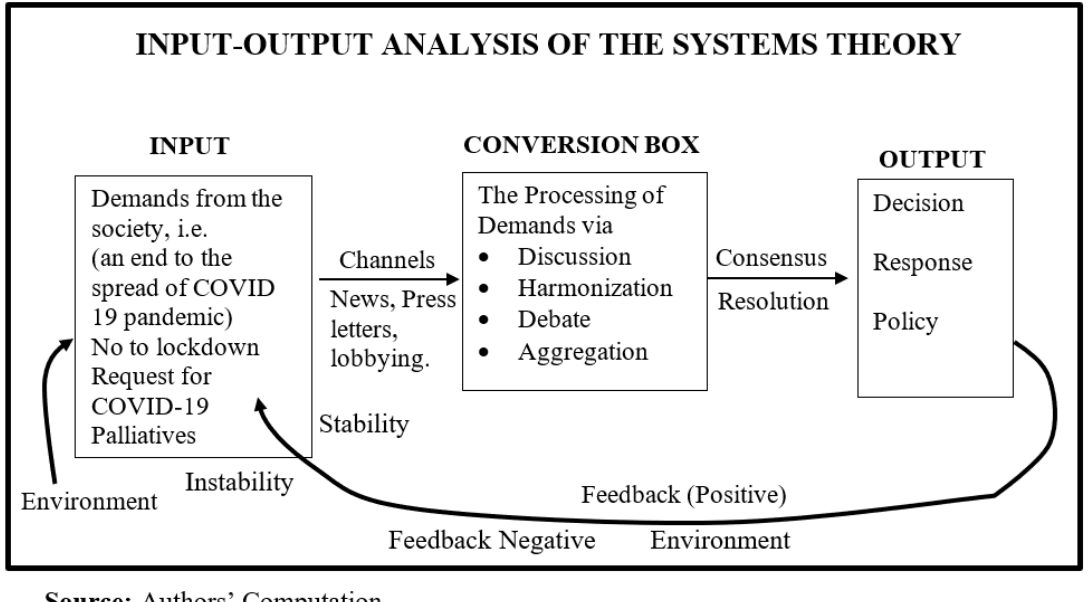
Figure 1. Systems theory.